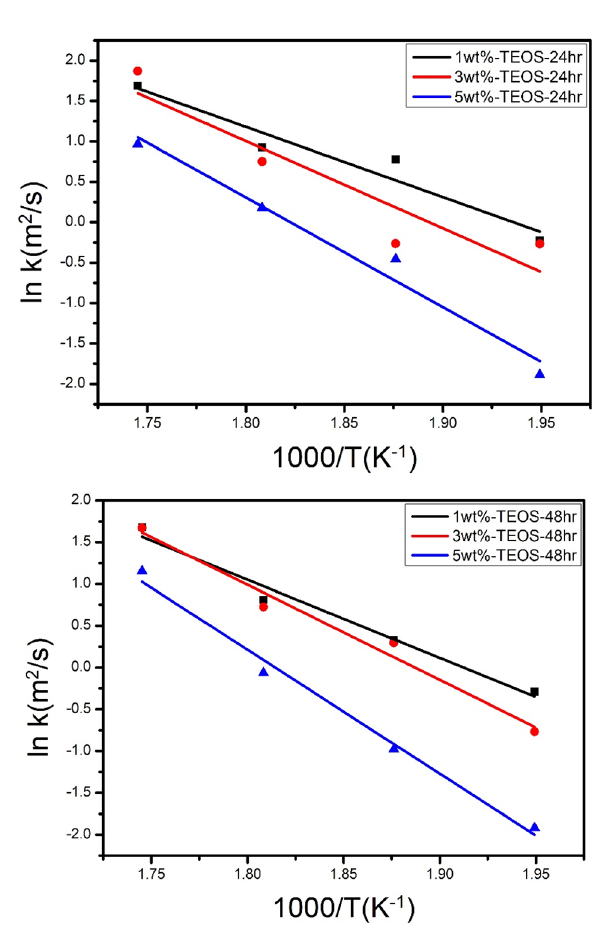
Fig. 10 Plots of ln k versus 1/T for samples after reaction for 24 and 48